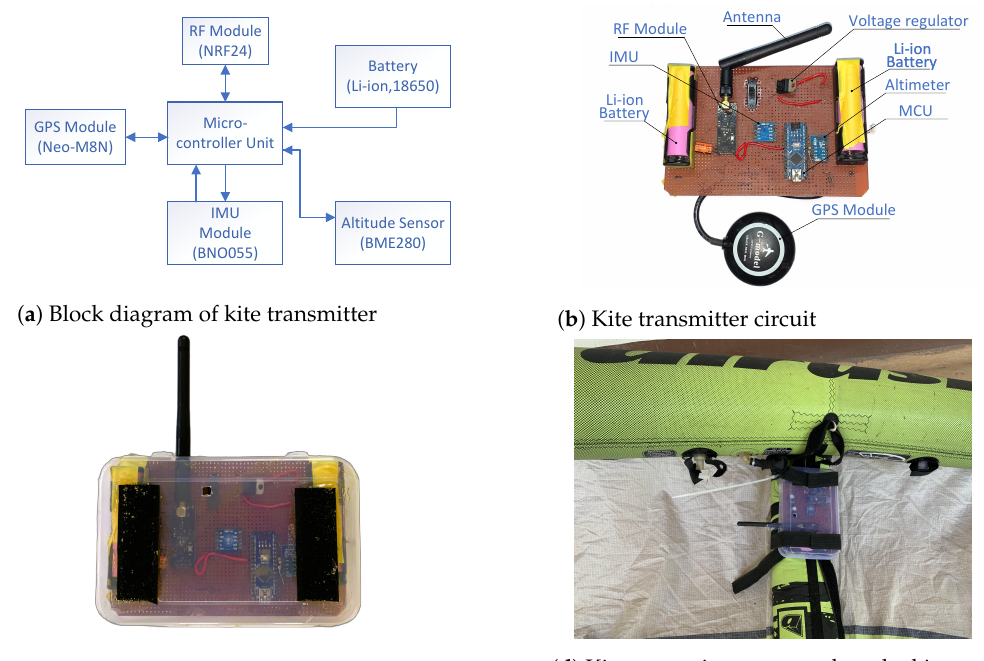
Figure 7. Sensor system on the kite: ( a ) block diagram of the system, ( b ) PCB implementation of the sensor system, ( c ) PCB enclosed within the box for protection, ( d ) Sensor system installed on the kite using